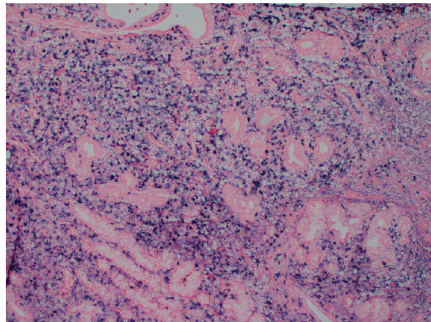
Figure 4: 40x of the EBER-ISH stain on gastric biopsy demon- strating PBL with extensive involvement by EBV.